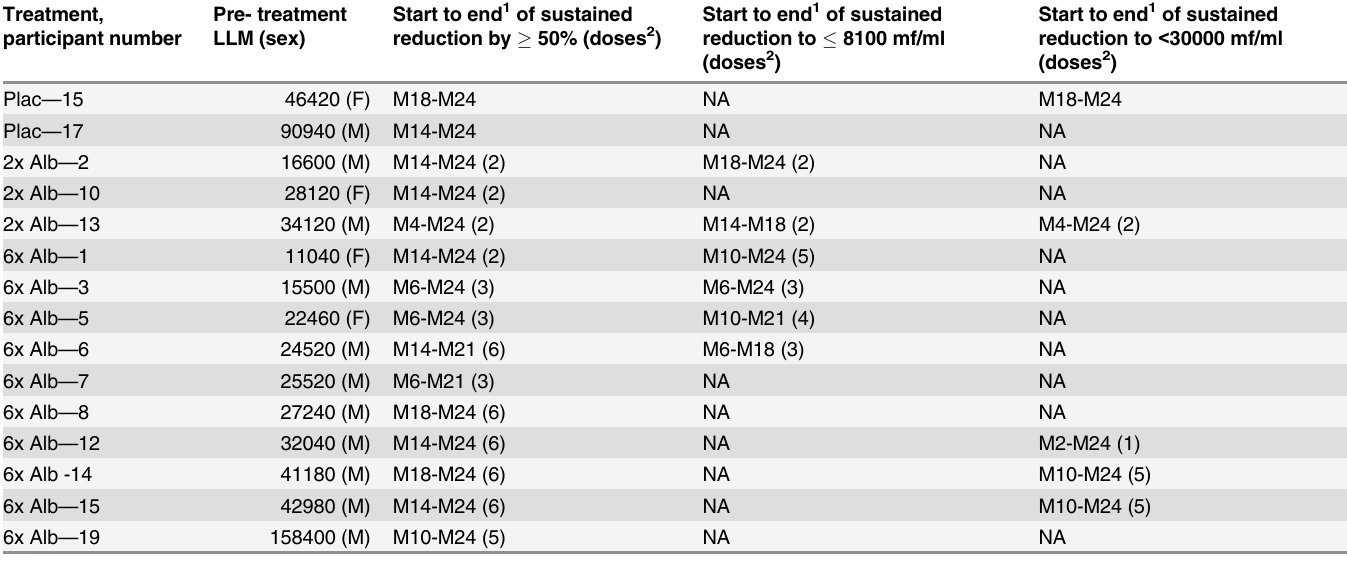
1 Start and end are provided as the month M of the fi rst and last measurement of the sustained LLM reduction. 2 Doses: number of albendazole doses received before the start of the sustained reduction. The fi rst dose was given at M0 NA: not achieved or not applicable (for reduction to < 30000 mf/ml for participants with < 30000mf/ml pre-treatment LLM)